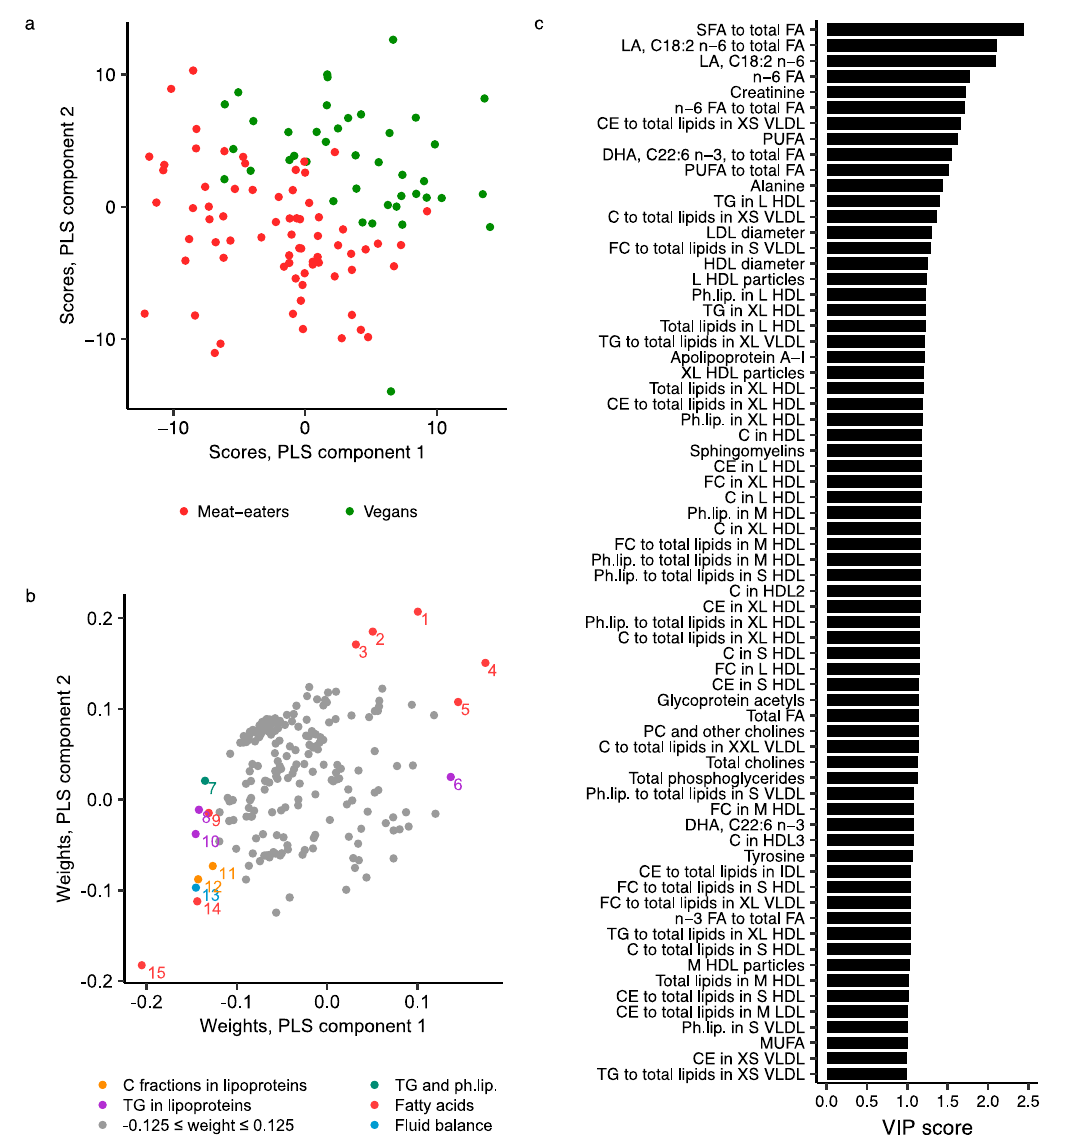
Figure 5. PLS model of 207 NMR metabolite measurements in meat-eaters and vegans. ( a ) Score plot of PLS components 1 and 2 coloured by diet group; ( b ) Weights plot of PLS components 1 and 2. Metabolites with weights more extreme than ±0.125 on either PLS component are coloured and labelled: 1, Linoleic acid, C18:2 n-6; 2, n-6 fatty acids; 3, Polyunsaturated fatty acids; 4, Linoleic acid, C18:2 n-6, to total fatty acids; 5, n-6 to total fatty acids; 6, Triglycerides to total lipids in XL VLDL; 7, Sphingomyelins; 8, Triglycerides in XL HDL; 9, DHA, C22:6 n-3; 10, Triglycerides in L HDL; 11, Total cholesterol to total lipids in XS VLDL; 12, Cholesterol esters to total lipids in XS VLDL; 13, Creatinine; 14, DHA, C22:6 n-3, to total fatty acids; 15, Saturated to total fatty acids; ( c ) Variable influence on projection (VIP) scores, representing the contribution of metabolites to the PLS model; metabolites with VIP > 1 are included in the plot. Further details are given in Table S5. Abbreviations: C, total cholesterol; CE, cholesterol esters; C fractions, cholesterol fractions, i.e., total cholesterol, cholesterol esters and free cholesterols; DHA, docosahexaenoic acid; FA, fatty acids; FC, free cholesterol; HDL, high-density lipoprotein; IDL, intermediate-density lipoprotein; L, large; LA, linoleic acid; LDL, low-density lipoprotein; M, medium; MUFA, monounsaturated fatty acids; Ph.lip., phospholipids; PLS, partial least squares; PUFA, poly unsaturated fatty acids; S, small; SFA, saturated fatty acids; TG, triglycerides; VIP, variable influence on projection; VLDL, very-low-density lipoprotein; XL, extra-large; XS, extra-small; XXL, chylomicrons and extremely